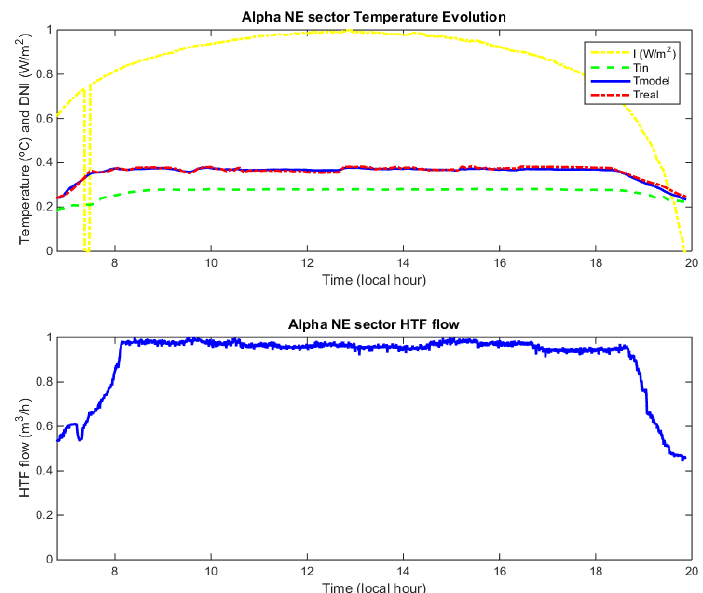
Figure 7. Alpha North-East sector, model vs. real evolution: ( top ) model (blue solid) and real (red dash-dotted); and ( bottom ) HTF